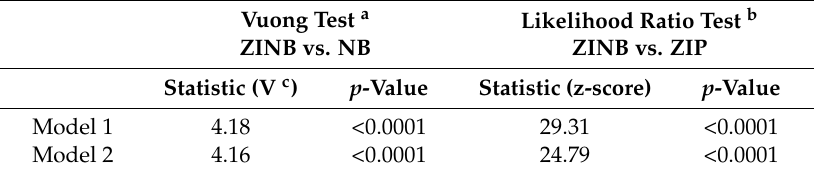
Table 5. Tests of ZINB model fit.